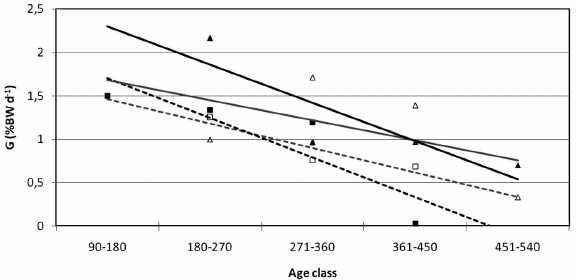
Fig. 8. – Eledone cirrhosa instantaneous relative growth rate (G) in BW (% BW d –1 ) and trending lines per 90-day age class. Full squares, west coast males (black dotted trend line); open squares, north coast males (grey dotted trend line); full triangles, west coast females (continuous black line); and open triangles, north coast fe- males (continuous grey